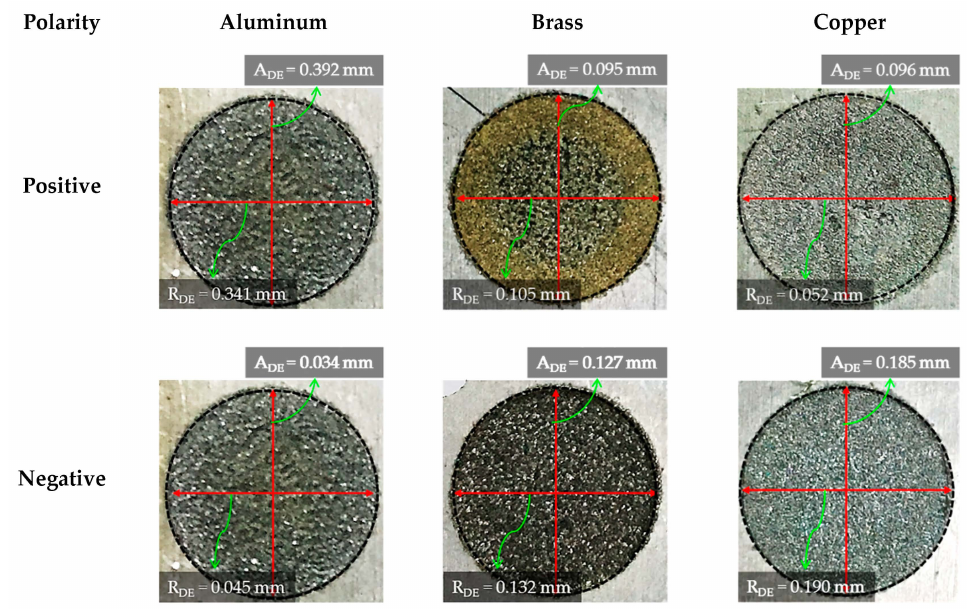
Figure 6. Effect of polarity on minimum values of dimensional errors obtained for each electrode.